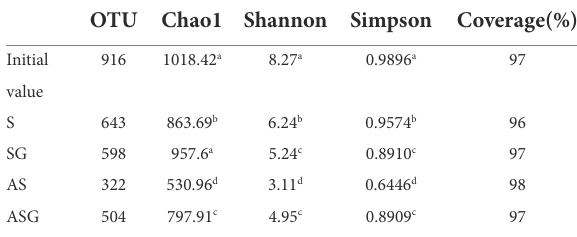
TABLE 4 Diversity index of microbial community in different treatment